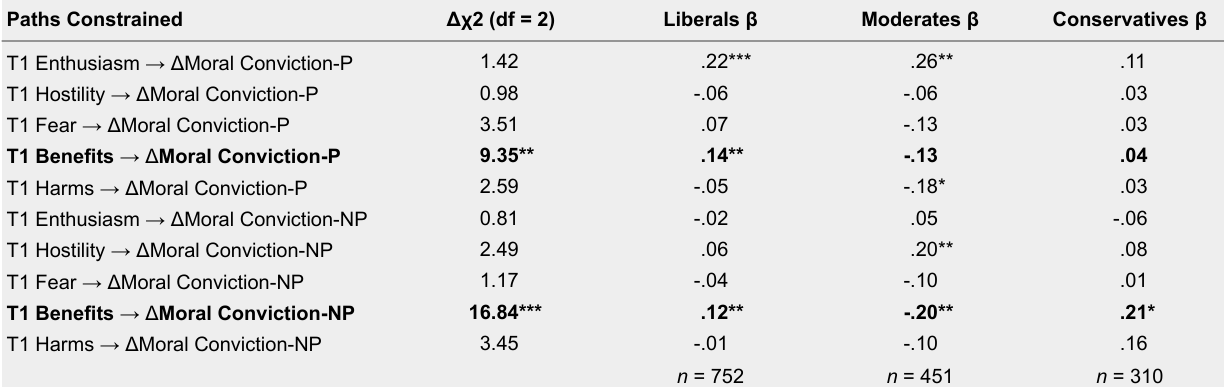
Tests of the Differences Between the Paths for Liberals, Moderates, and